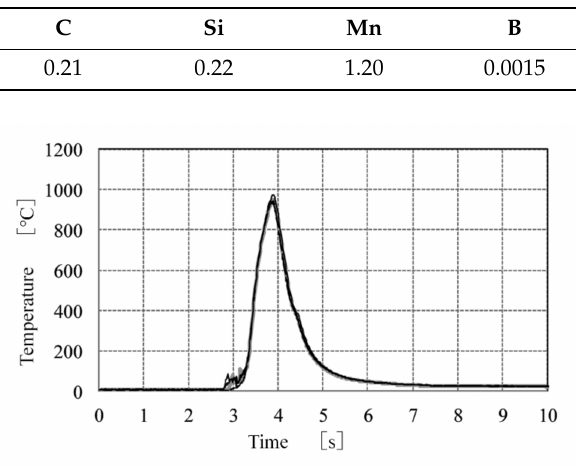
Table 2. Chemical compositions of material (mass %).